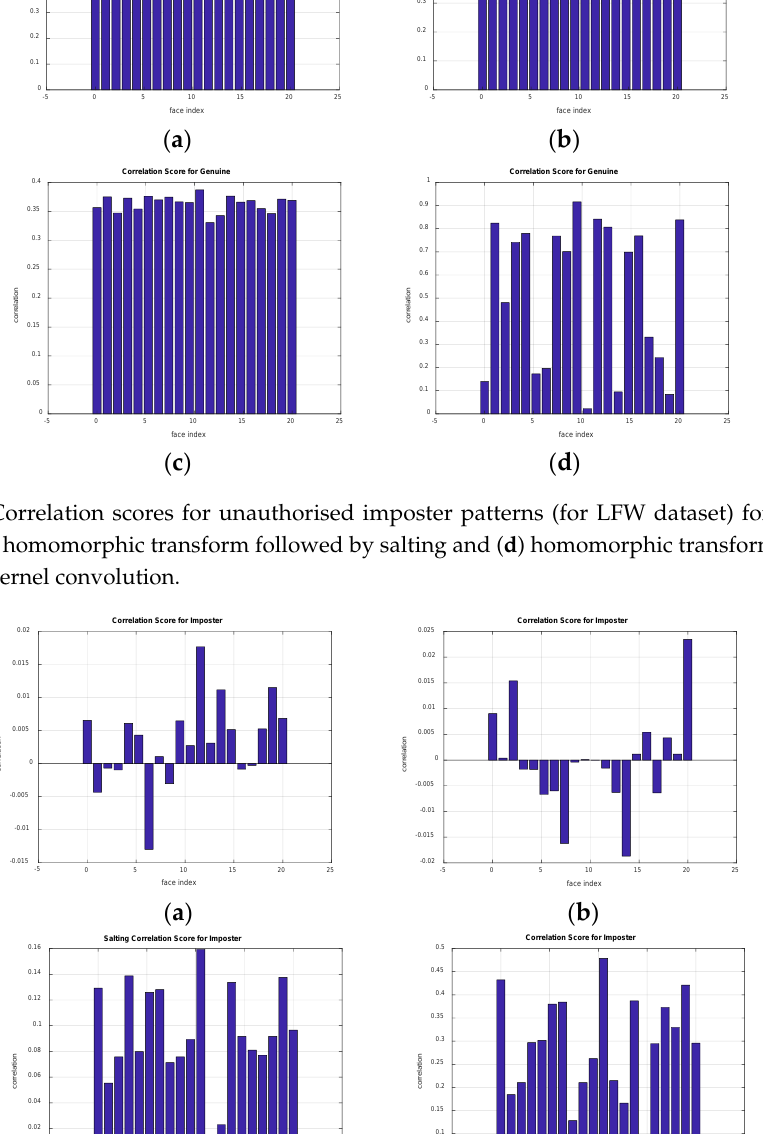
Figure 26. Correlation scores for unauthorised imposter patterns (for FERET dataset) for ( a ) CFR1, ( b ) CFR2, ( c ) homomorphic transform followed by salting and ( d ) homomorphic transform followed by random kernel convolution.